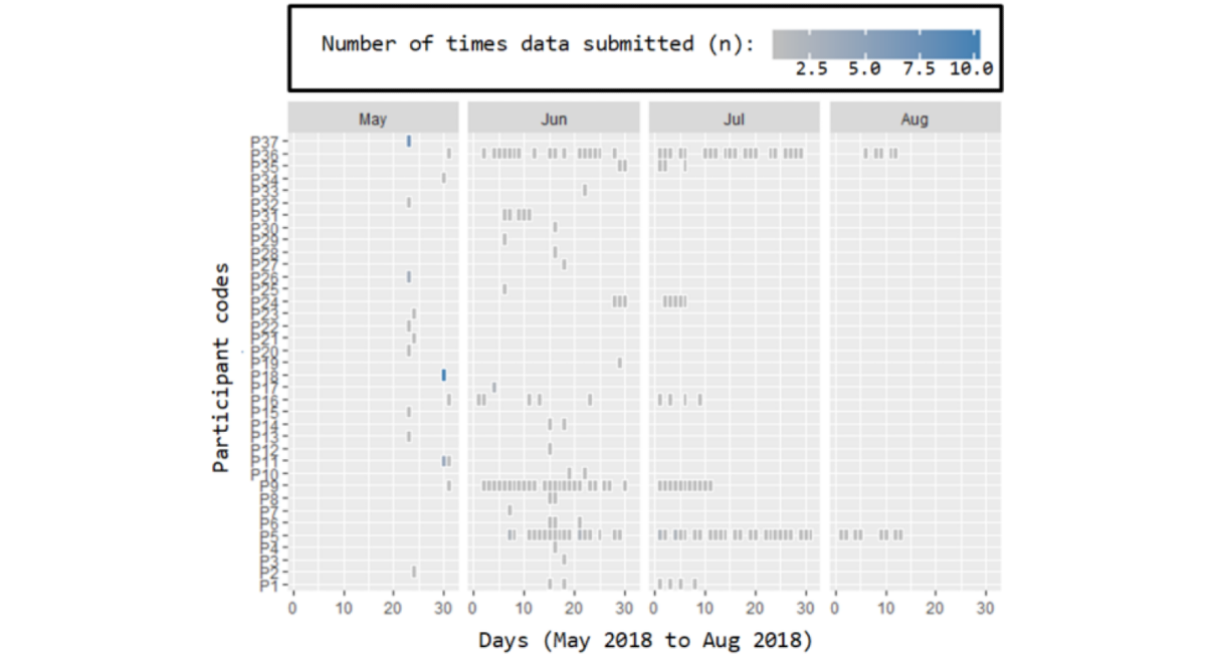
Figure 8. The number of times each participant submitted his or her self-reported symptom data per day per